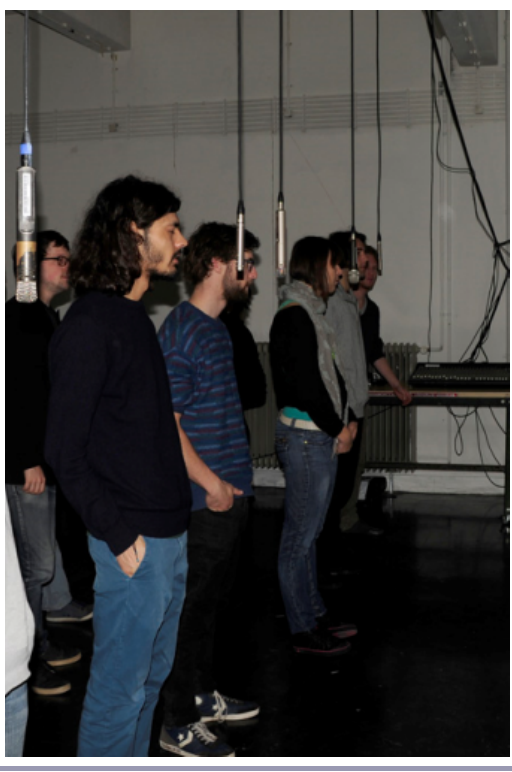
Fig. 8 . Breathing Feedbacks. Participants are asked to breathe into microphones, connected to speakers and a computer that analyses breathing patterns, after having done some exercise to get their breathing active.